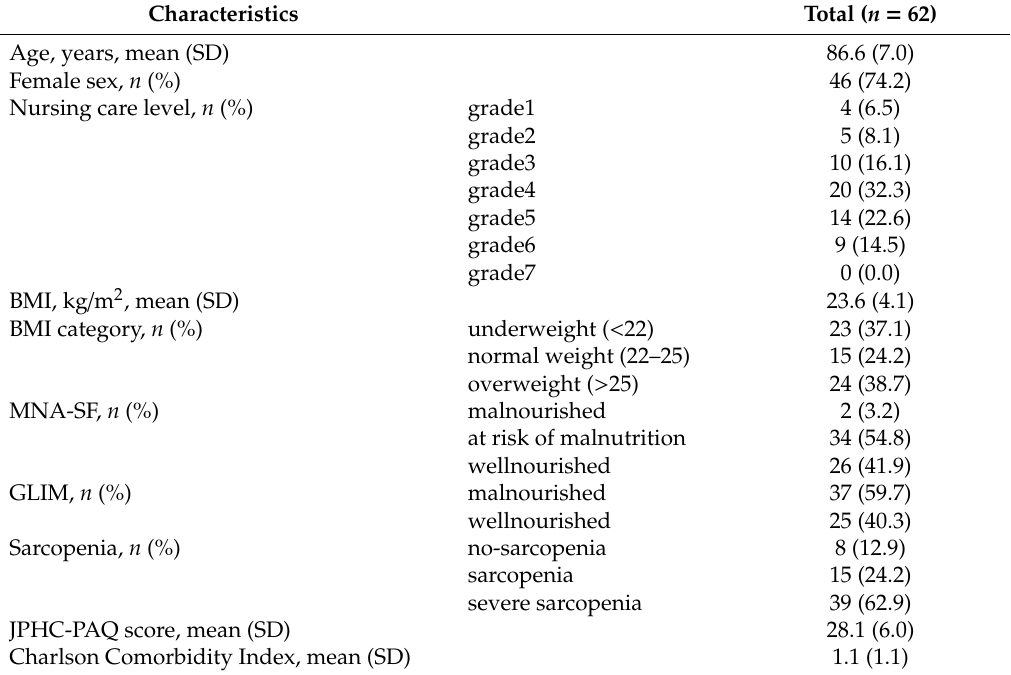
Table 1. Characteristics of the study